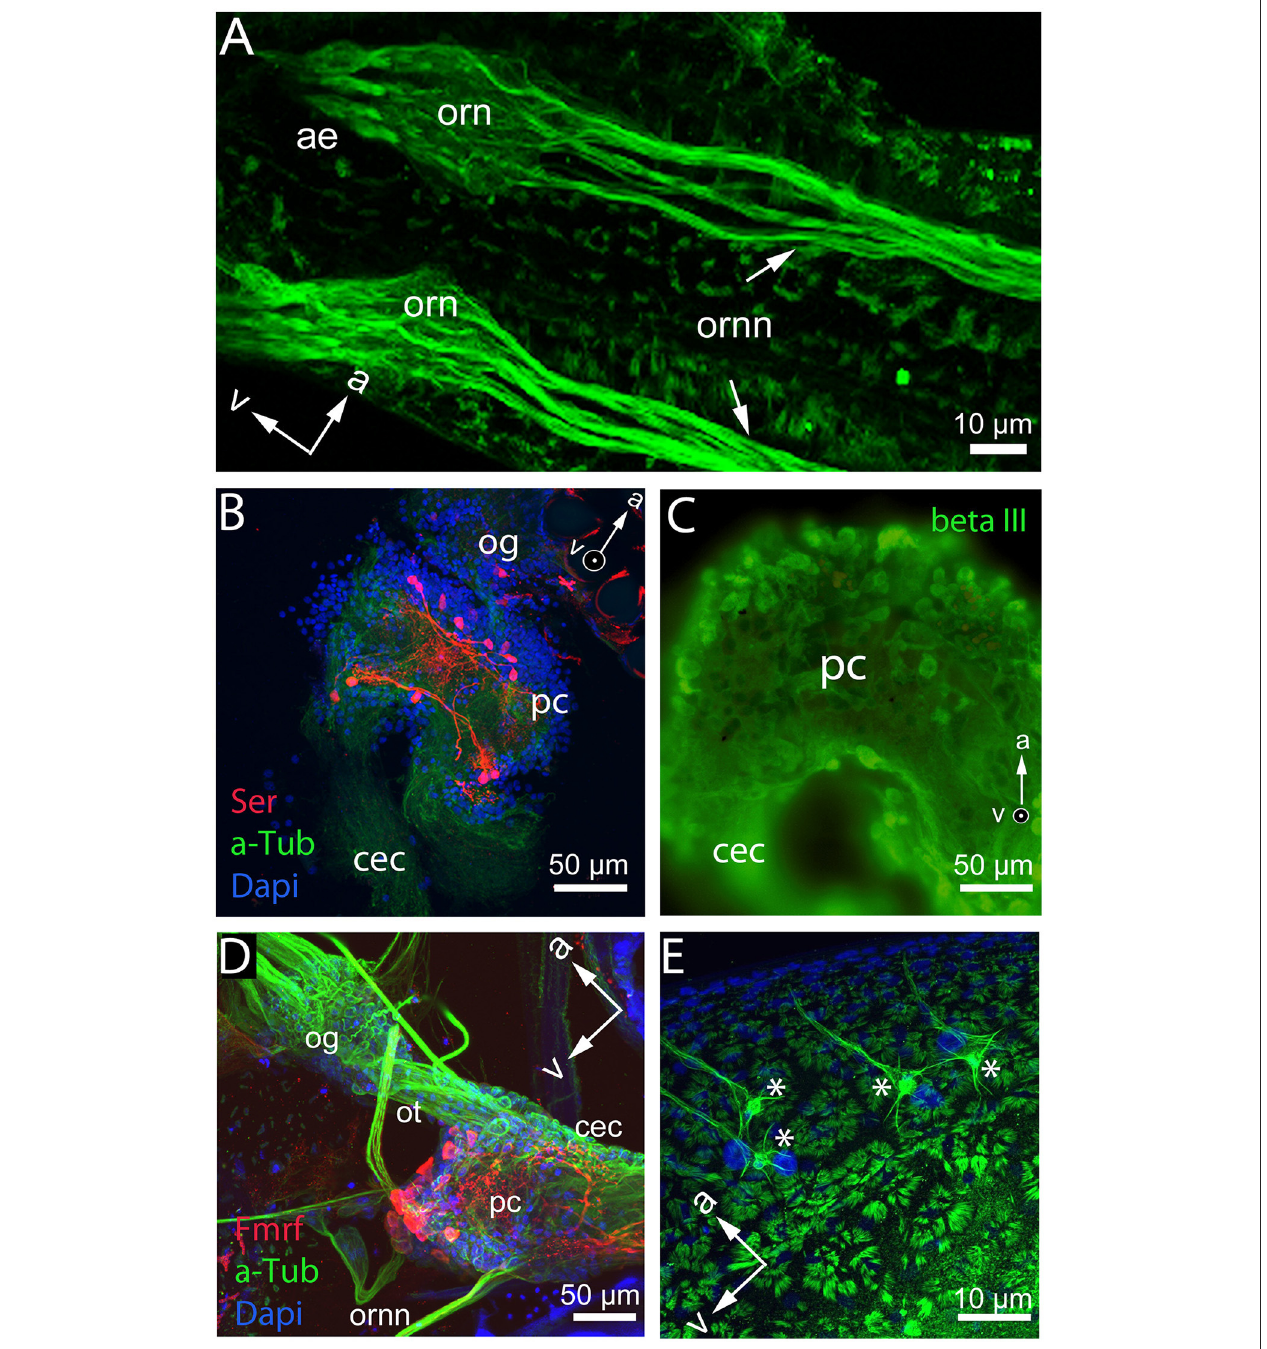
FIGURE 4 | Whole mount and brain mount preparation of the Daphnia nervous system displaying differential functional qualities of cells. (A) Base of the antennules and cuticular insertion of the aesthetascs (ae) with olfactory receptor neurons (orn) and olfactory receptor neuron neurites (ornn) extending from the first antennule to the deutocerebrum of the brain in D. longicephala . (B) Protocerebrum (pc) and optic ganglia (og) of D. magna show neurons stained with anti-serotonin antibody (red). Cytoskeleton is stained with anti-alpha tubulin (green) and nucleoli with dapi (blue). (C) Protocerebrum overview of the D. longicephala brain stained with an antibody detecting neuron-specific beta III tubulin. (D) Whole mount preparation of a D. longicephala head displaying the optic ganglia (og) connected via the optic tract (ot) with the protocerebrum (pc) extending into the circumesophageal connective that connects to the tritocerebrum (not shown). The olfactory receptor neurons connect to the central brain via the deutocerebrum. Nucleoli are stained in dapi displayed in blue, the cytoskeleton is stained with anti-alpha tubulin in green, and red displays cells with anti-Fmrfamide reactivity. (E) Polyploid cells (asterisks) lining the region of crest expression in D. longicephala stained with anti-alpha tubulin. Cells are characterized by a large nucleus stained with dapi (blue), lateral extensions, and one dominant extension innervating the epidermal cells of the crest. Orientation of the preparations is marked by arrows in the anterior (a) and ventral (v) directions. Images by Ioannidou & Weiss.